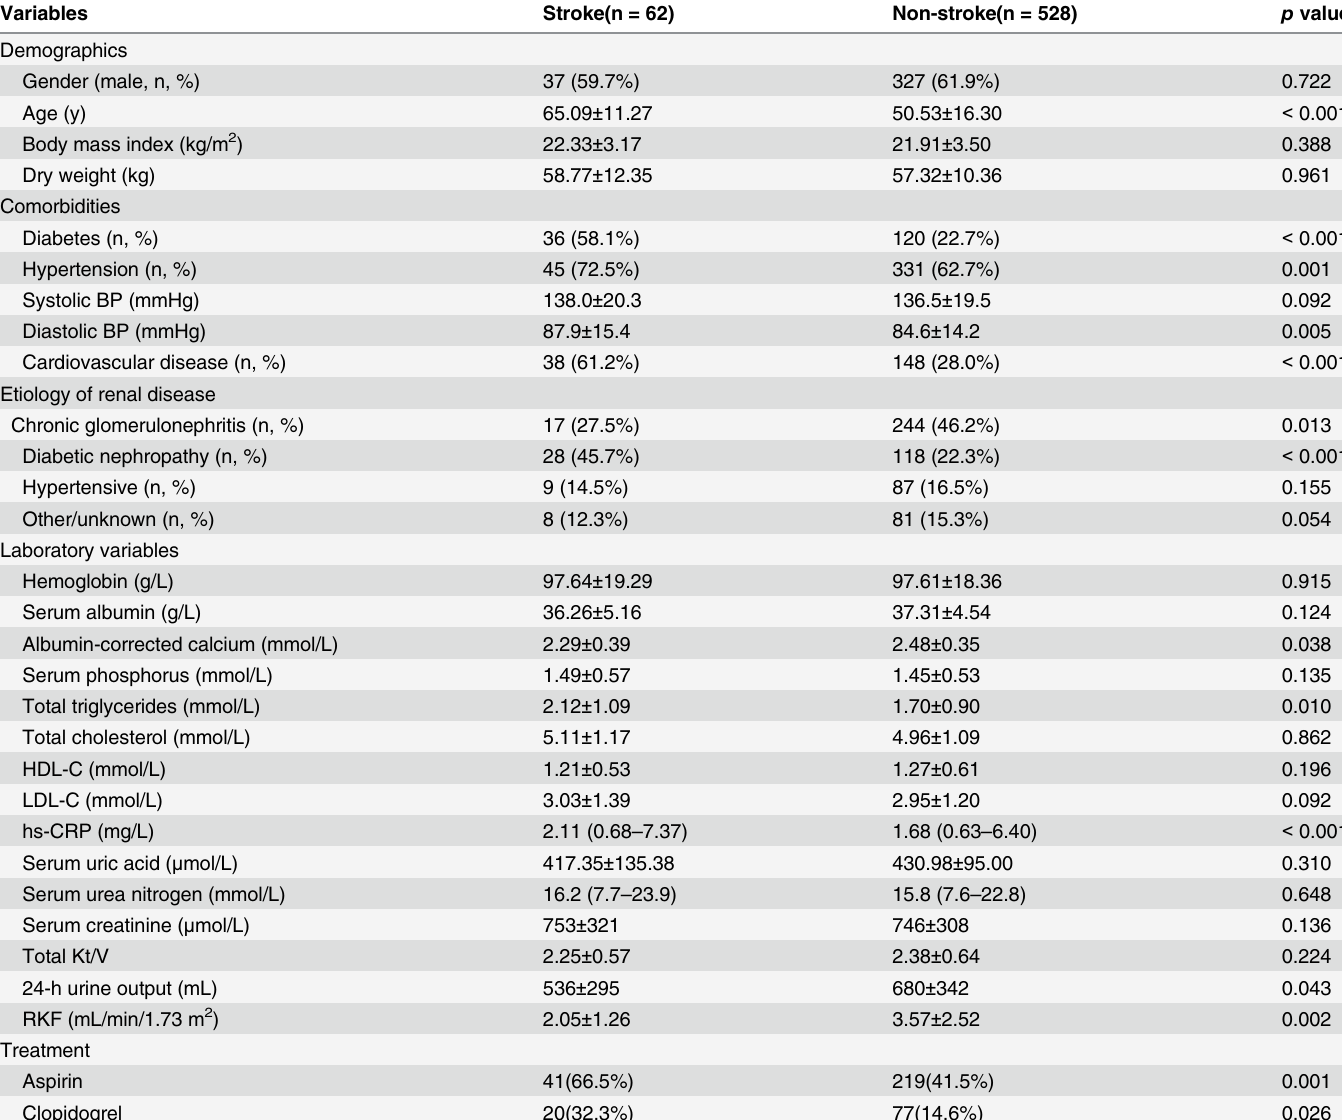
Table 3. Comparative baseline characteristics of patients with and without